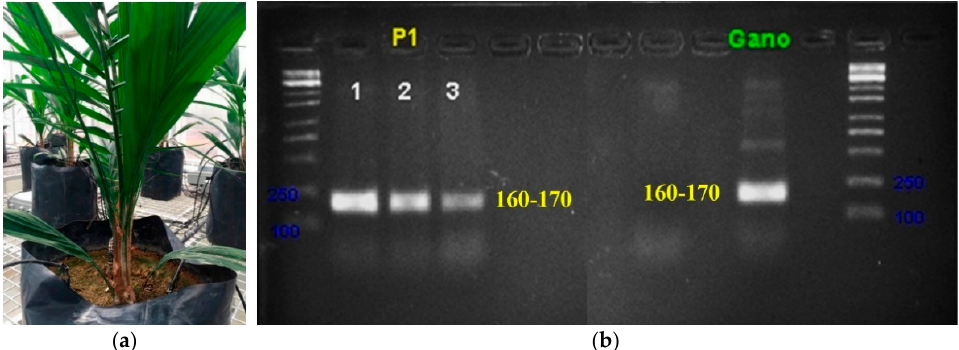
Figure 1. Sample of an infected seedling. ( a ) Condition of an infected seedling without symptoms i.e., no fruiting bodies and yellowing of older leaves. However, the disease is confirmed by the ( b ) PCR amplification using specific primer of G. boninense .